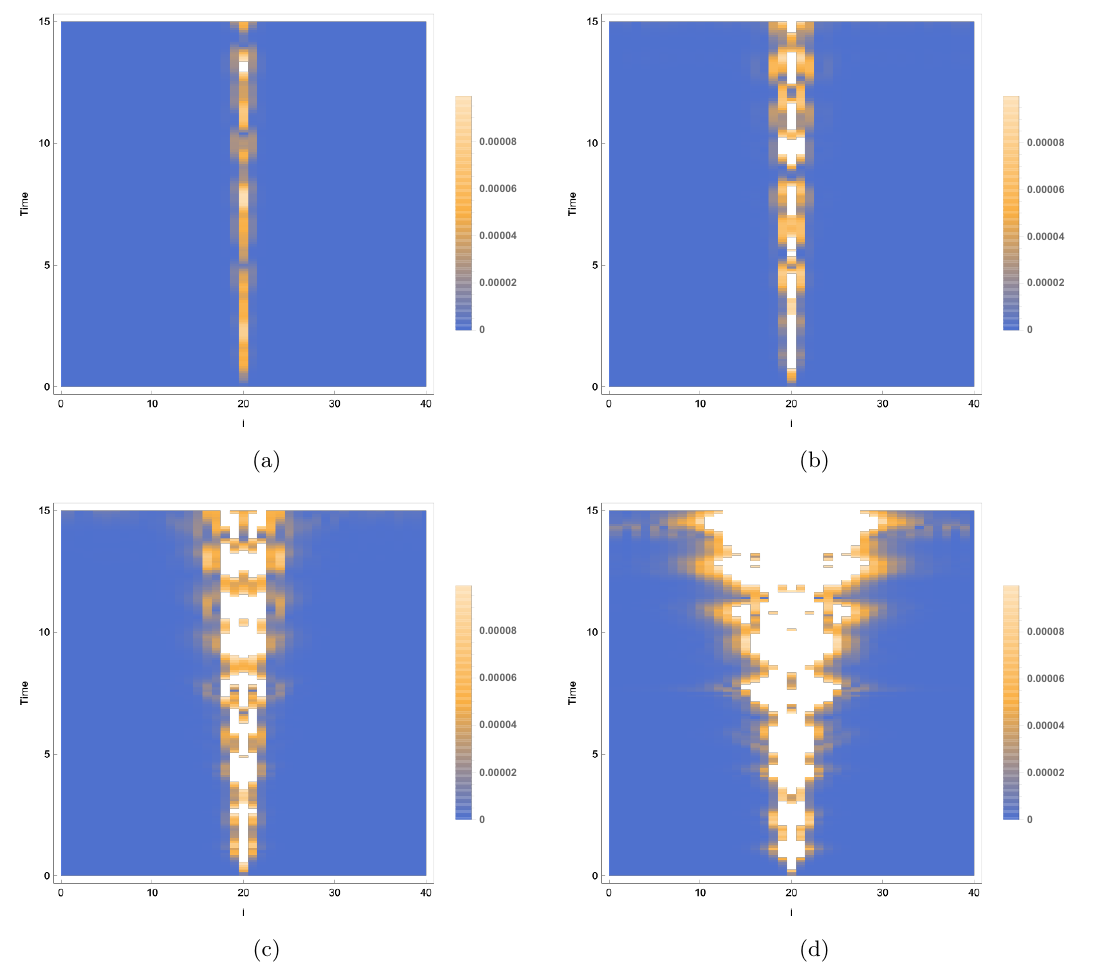
Figure 12 . The relative local energy density (cid:1) h i ( t ) plotted in the space of i and t for the initial condition in eq. (4.1) with R = U = (cid:21) = 1, Q = 10 (cid:0) 3 and L = 40 for (a) (cid:15) = 0 : 08, (b) (cid:15) = 0 : 12, (c) (cid:15) = 0 : 16 and (b) (cid:15) = 0 :